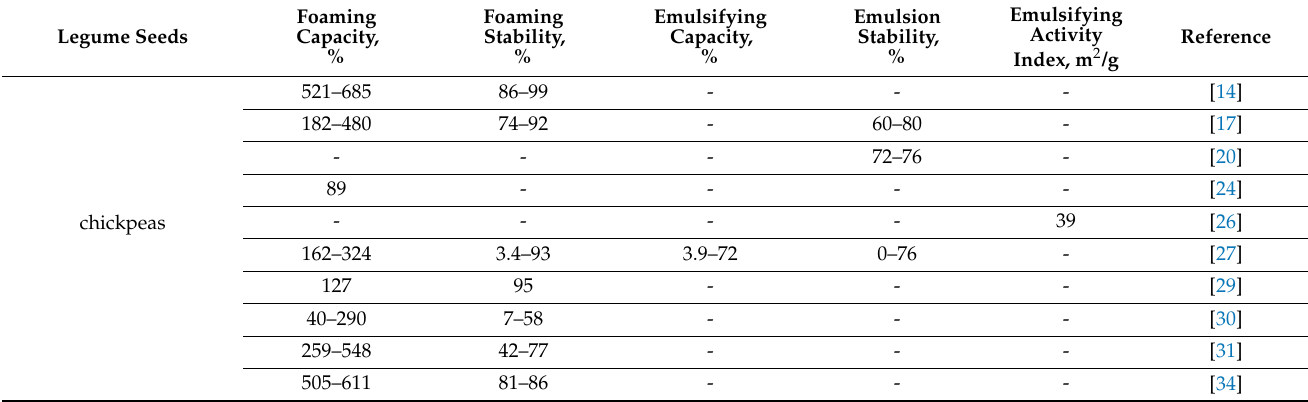
Table 3. Foaming and emulsifying properties of aquafaba.